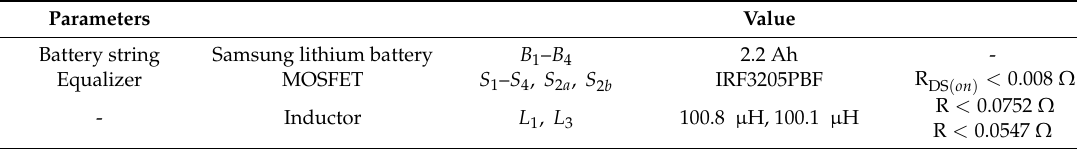
Table 10. Component values used for the equalizer.